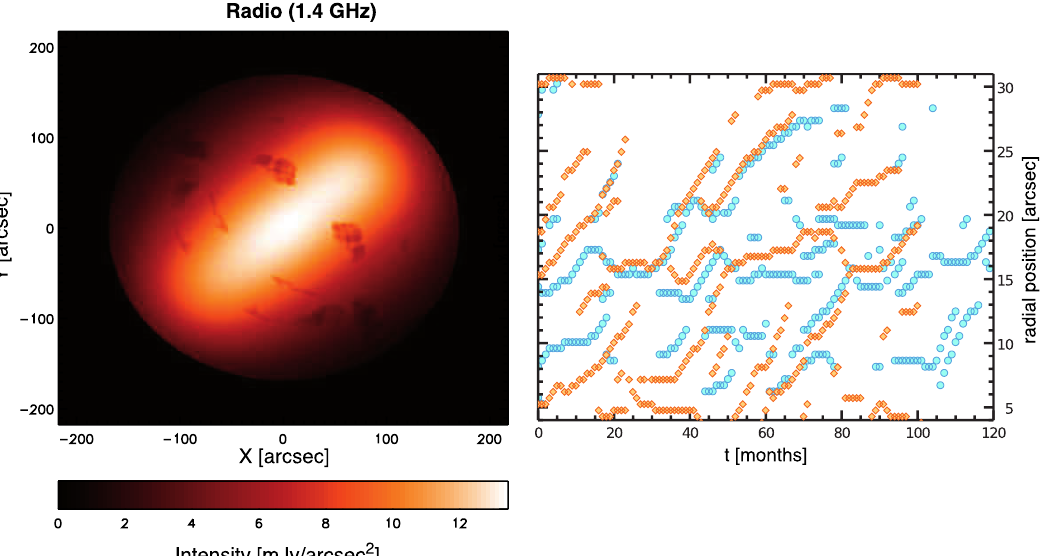
Figure 7. Left panel: Surface brightness map at a 1.4 GHz radio frequency. Small scales have been subtracted and the map convolved with the VLA PSF. The intensity is given in linear scale and in mJy/arcsec 2 units. The emitting particles are assumed as uniformly distributed in the nebula. Right panel: Non-coincidence of the X-ray (aquamarine circles) and radio at 5 GHz (orange diamonds) wisps, produced by particles accelerated in the regions highlighted with the same colors in the left panel of Figure 3. More discussion on this can be found in [88]. The map in the left panel is reprinted with permission from Olmi et al. (2014) © 2014 Olmi et